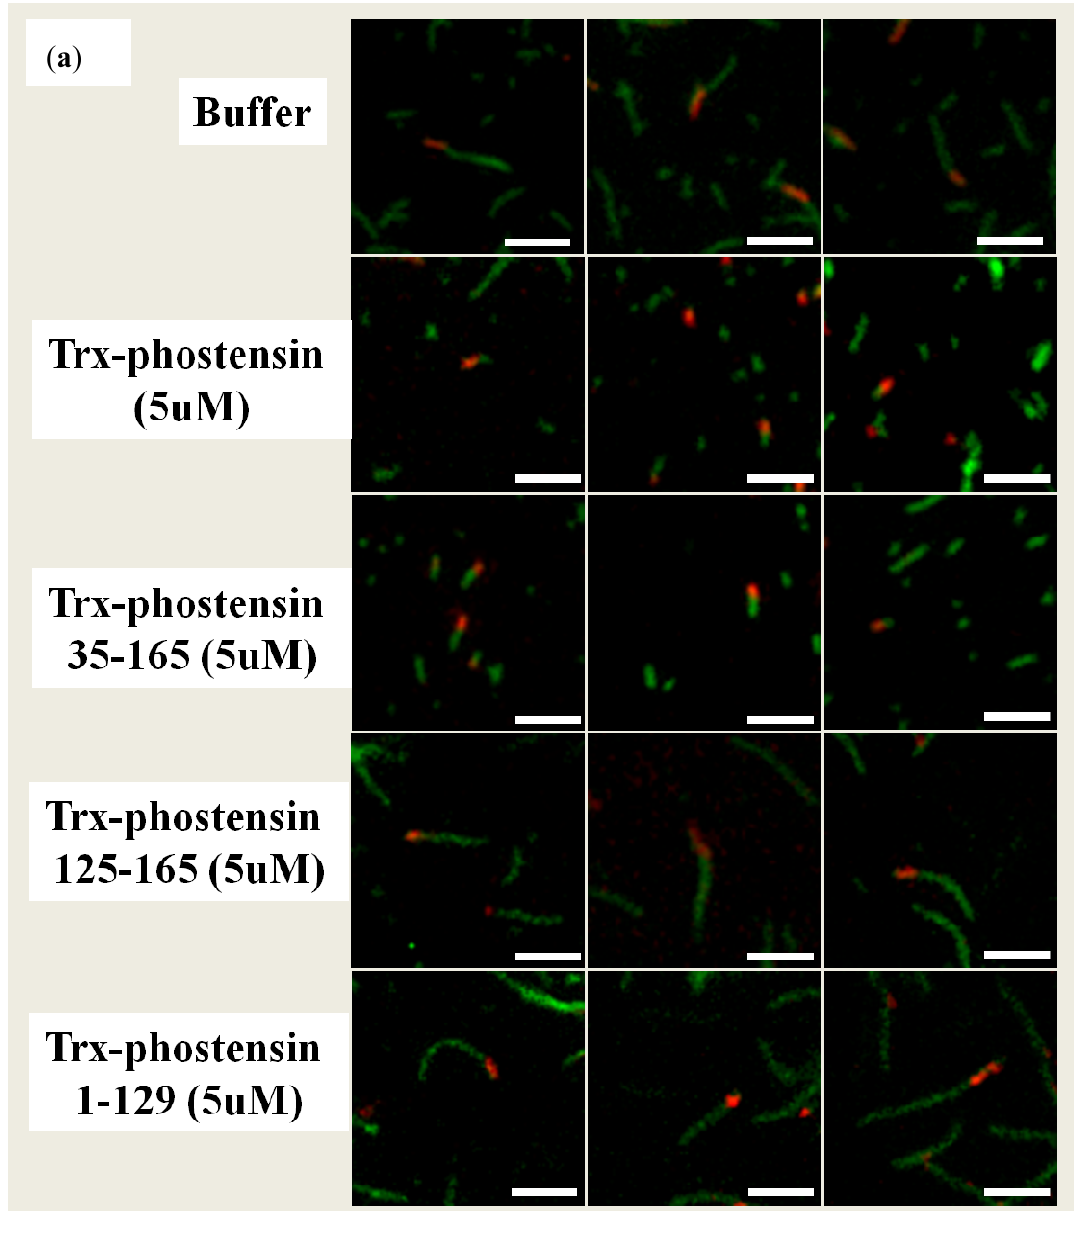
Figure 5. Trx-PT(125–165) and trx-PT(1–129) cannot impede the elongation rates of pointed ends. ( a ) Trx-PT(125–165) and trx-PT(1–129) cannot retard the pointed end elongation of gelsolin-actin seeds. However, under the same conditions, trx-PT and trx-PT(35–165) impede the elongation rates of pointed ends. The bar represents 3 μ M; ( b ) The elongation rates (mean ± SD) of pointed ends in the presence of buffer (1.66 ± 0.16 μ m/min, n = 50), trx-PT in buffer (0.34 ± 0.07 μ m/min, n = 60), trx-PT(35–165) in buffer (0.36 ± 0.05 μ m/min, n = 69), trx-PT(125–165) in buffer (1.64 ± 0.17 μ m/min, n = 65) or trx-PT(1–129) in buffer (1.67 ± 0.13 μ m/min, n = 50). The lengths of the growing actin filaments (green fluorescence) were obtained from data presented in (a).